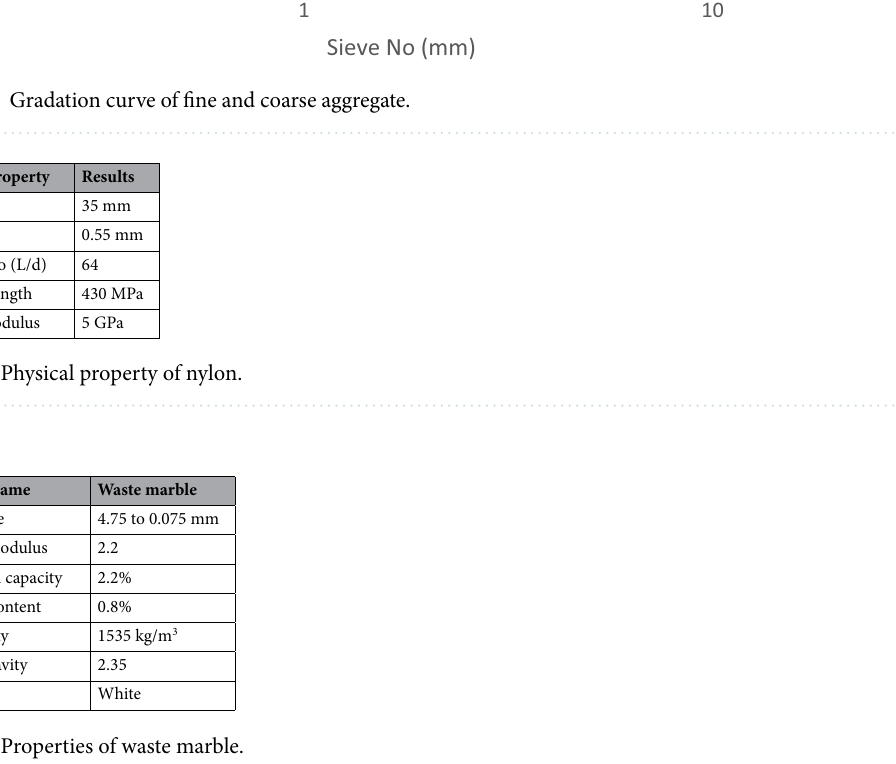
Table 5. Properties of waste